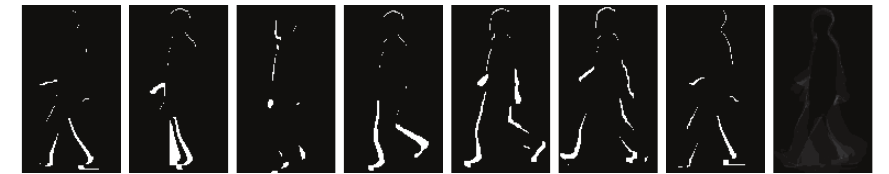
Figure 2: Differential images and average gait differential